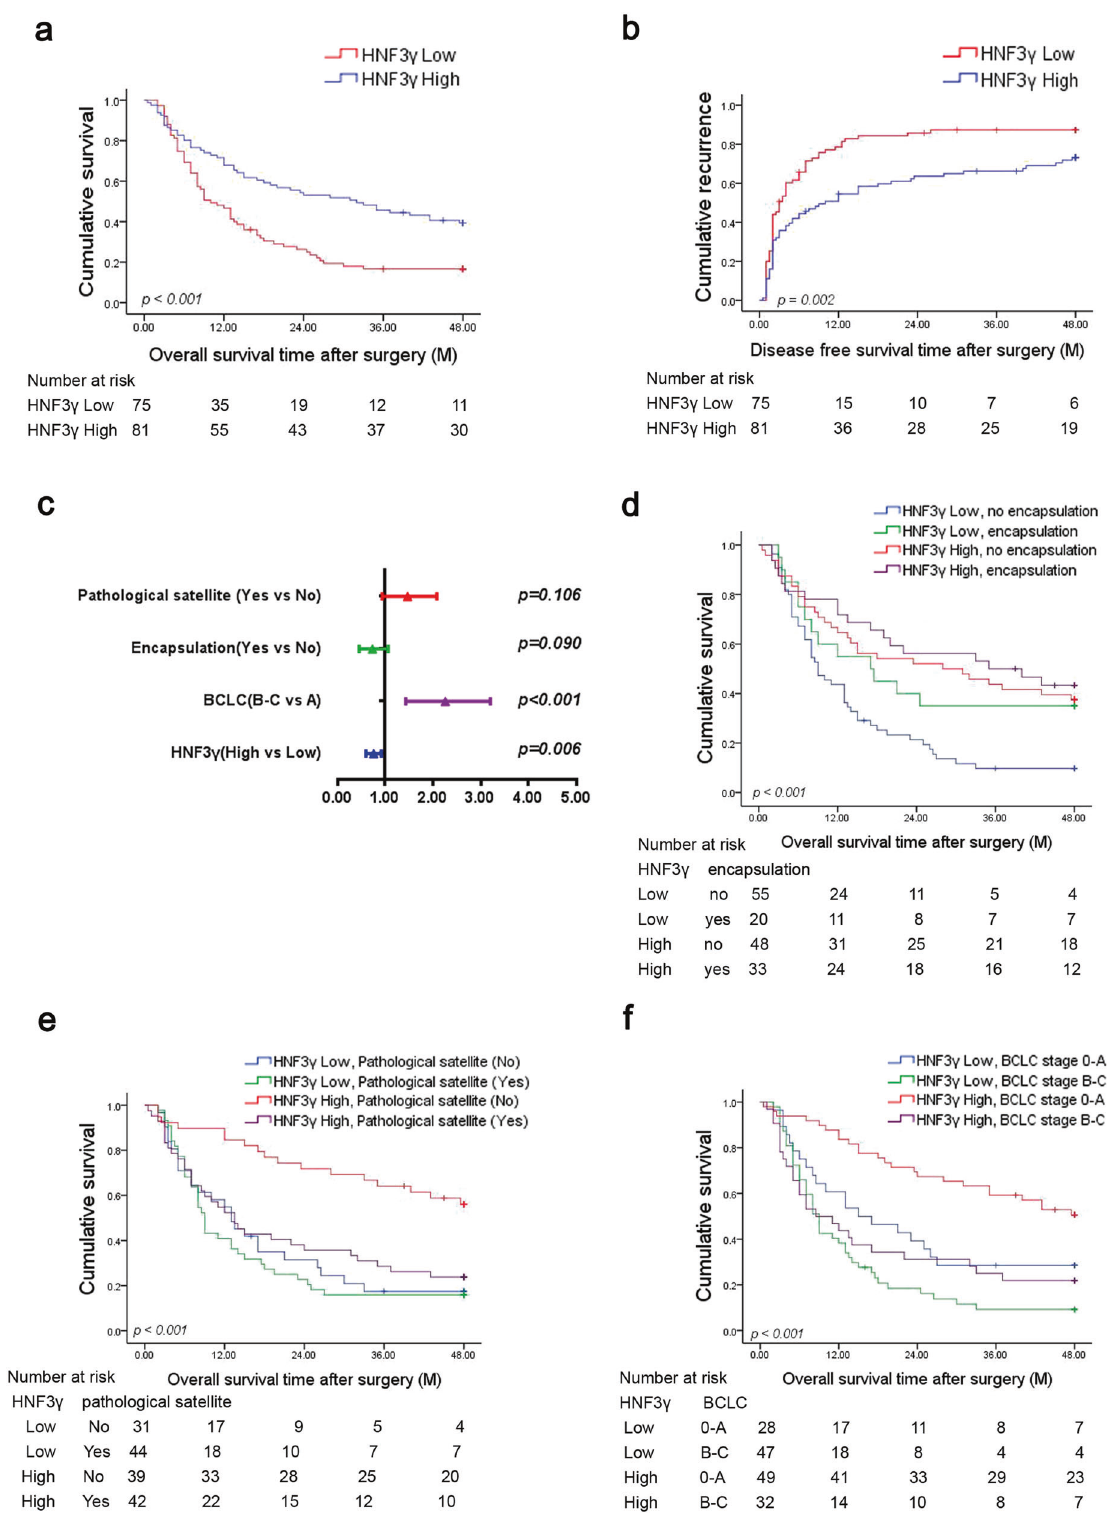
Fig. 2 High HNF3 γ levels predict a superior patient prognosis. a , b Overall survival and disease-free survival time after surgery of HCC patients were compared between the “ HNF3 γ low ” ( n = 75) and “ HNF3 γ high ” ( n = 81) groups using Kaplan – Meier analysis. c Multivariate analysis of overall survival of HCC patients in Cohort 1. d – f Overall survival rates of HCC patients were compared between subgroups using Kaplan – Meier